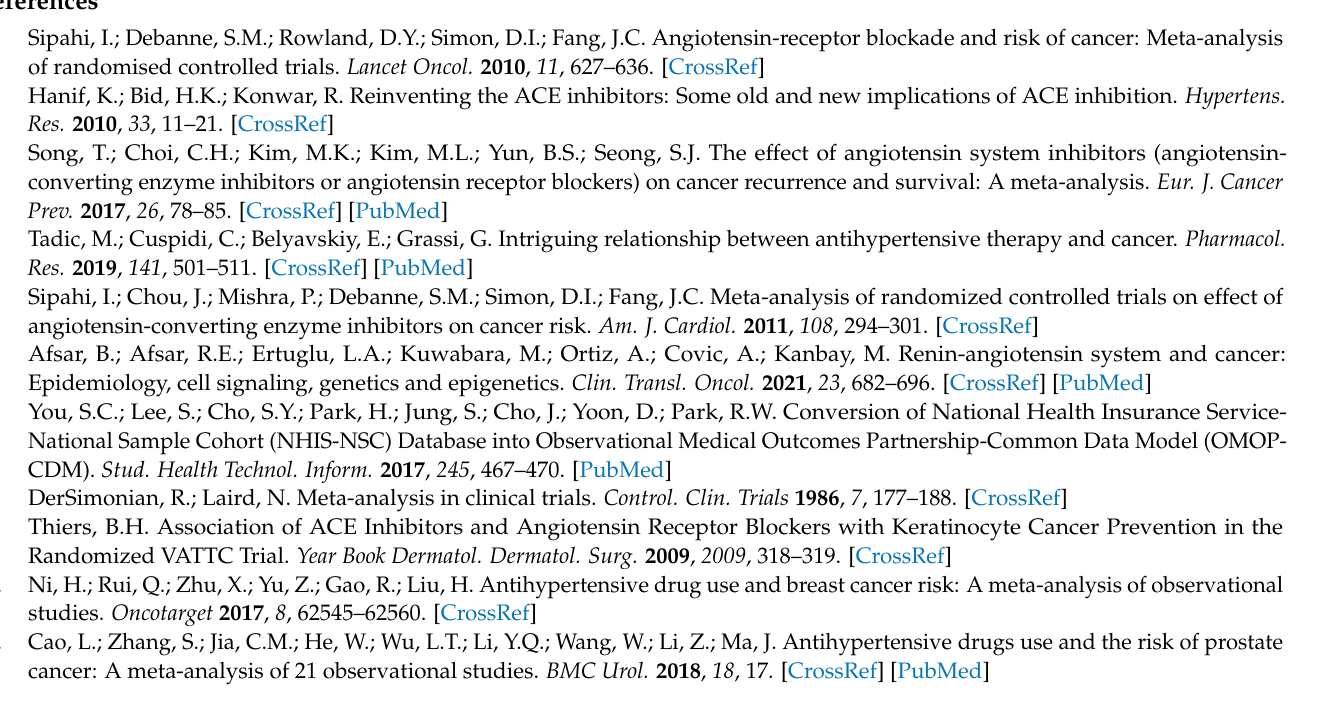
entire cohort (A) adjusted for sex and age, (B) propensity score stratified and (C) propensity-score matched population. Figure S9: Incidence rate of colon cancer in the entire cohort (A) adjusted for sex and age, (B) propensity score stratified and (C) propensity-score matched population. Figure S10: Incidence rate of gastric cancer in the entire cohort (A) adjusted for sex and age, (B) propensity score stratified and (C) propensity-score matched population. Figure S11: Incidence rate of liver cancer in the entire cohort (A) adjusted for sex and age, (B) propensity score stratified and (C) propensity-score matched population. Figure S12: Incidence rate of lung cancer in the entire cohort (A) adjusted for sex and age, (B) propensity score stratified and (C) propensity-score matched population. Figure S13: Incidence rate of gynecological cancer in the entire cohort (A) adjusted for sex and age, (B) propensity score stratified and (C) propensity-score matched population. Figure S14: Incidence rate of pancre- aticobiliary cancer in the entire cohort (A) adjusted for sex and age, (B) propensity score stratified and (C) propensity-score matched population. Figure S15: Incidence rate of prostate cancer in the entire cohort (A) adjusted for sex and age, (B) propensity score stratified and (C) propensity-score matched